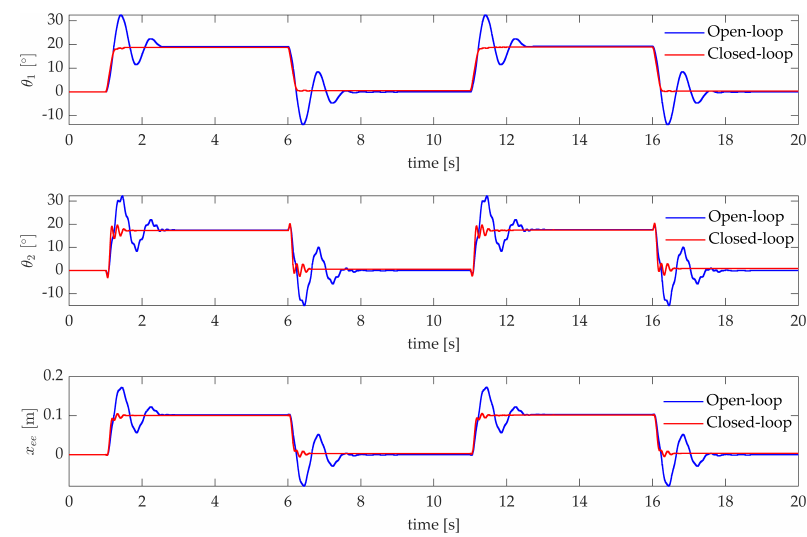
Figure 14. Test case 2: experimental pick-and-place